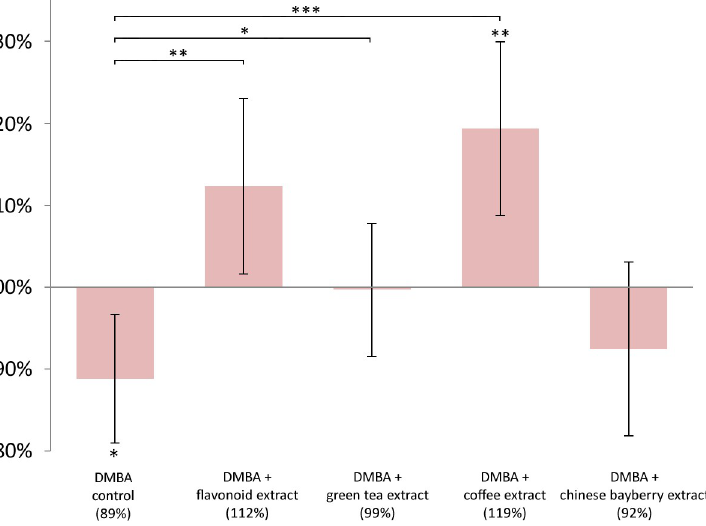
Fig 3. LINE -1 methylation pattern in the kidneys of mice. LINE-1 methylation pattern in the kidneys of CBA/Ca female mice (n = 6) due to the effect of DMBA, flavonoid extract, green tea extract, coffee extract and chinese bayberry extract, expressed as the ratio of untreated control ( � p < 0.05, �� p < 0.005, ��� p < 0.001).